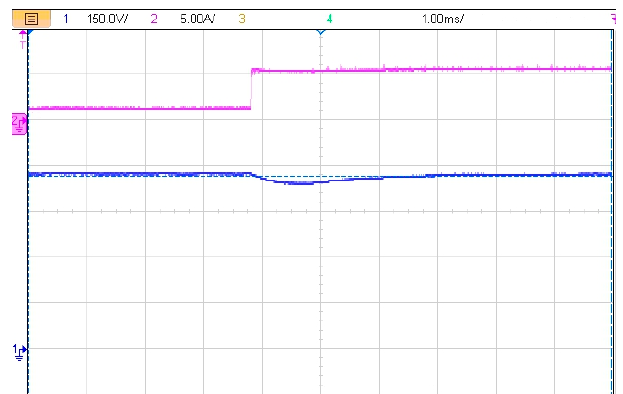
Energies 2019 , 12 , x 13 of 16 Figure 15. Output voltage 𝑉 (cid:3042) (purple-Scale: 300 V/div) and output current 𝐼 (cid:3042) (blue-Scale: 10 A/div). Total time: 200 ms.